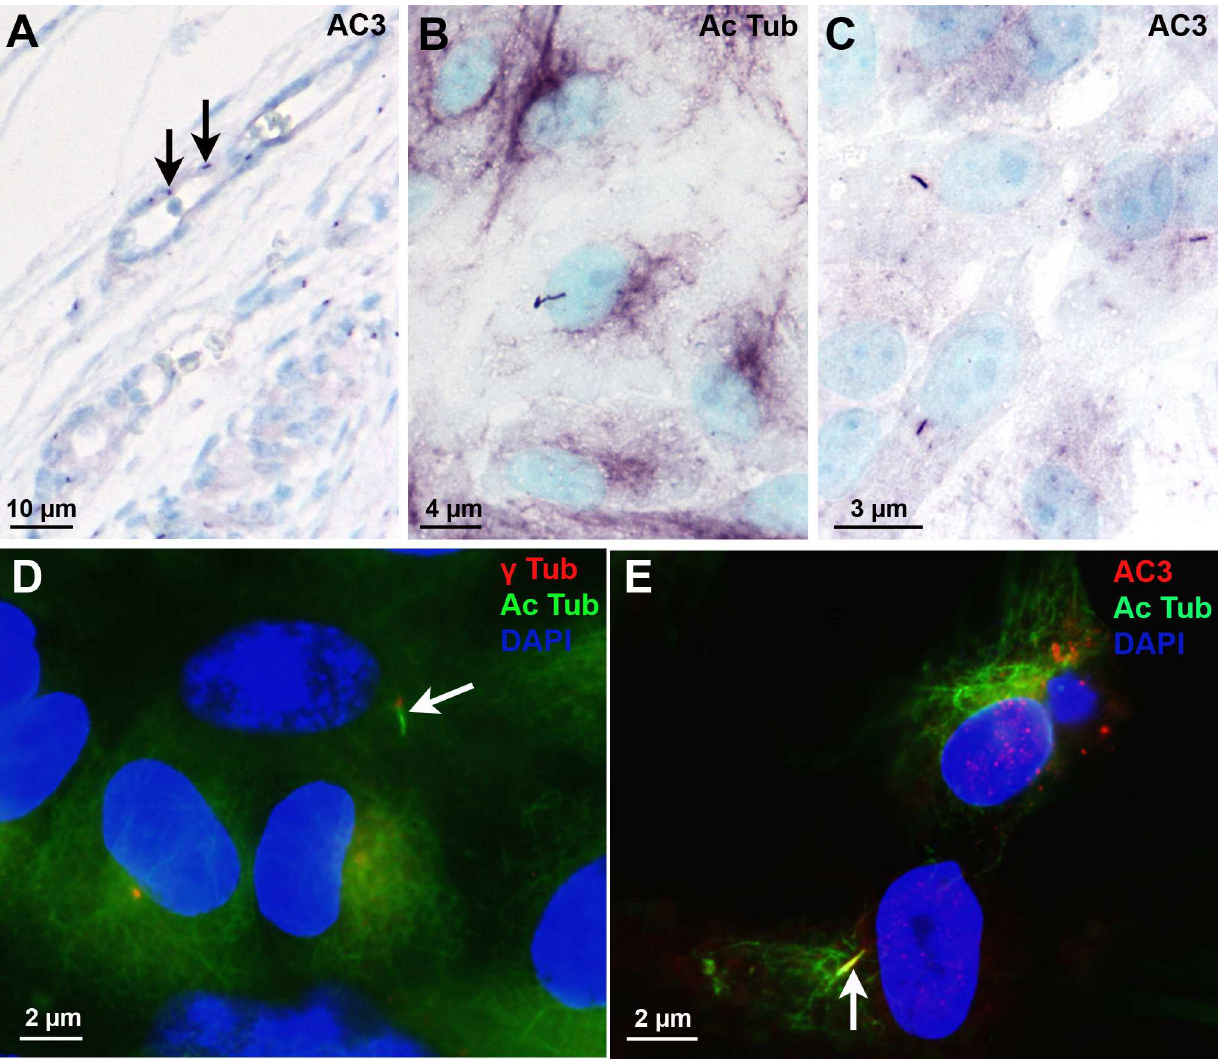
Fig 5. Endothelial cells cilia. (A) Short AC3-positive cilia (arrows) on some endothelial cells in a GW8 humanembryo. (B-E) Endothelialcells culture. (B) One cell displaysan acetylated tubulin-positiveprimary cilium. (C) Three adjacent cells displayan AC3-positive cilium. (D) One cell extends a primary cilium (arrow) from the gamma tubulin-labelled centrosome. (E) Only one of the three cells displaysa primary cilium which is AC3 positive (arrow). Abbreviations: AC3: adenylate cyclase type III; Ac Tub: acetylated-tubulin; γ Tub: gamma